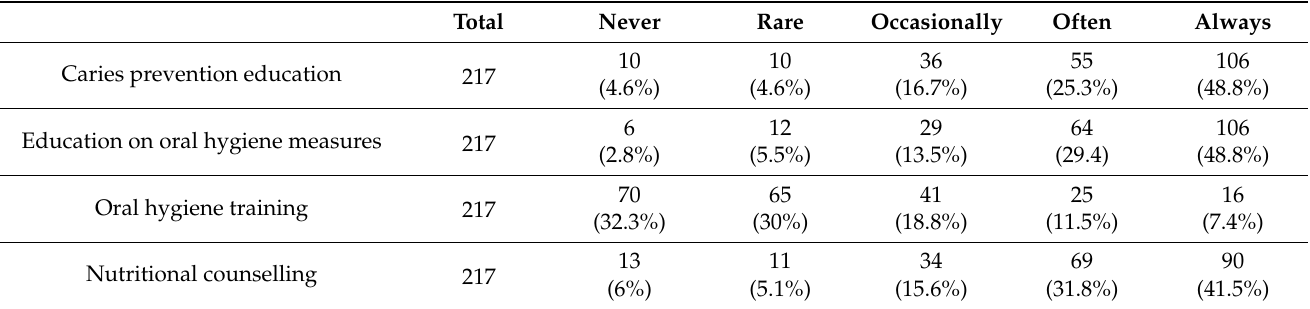
Table 5. Measures carried out in children between 6 and 33 months as part of caries prevention in absolute values and in percentages (%).